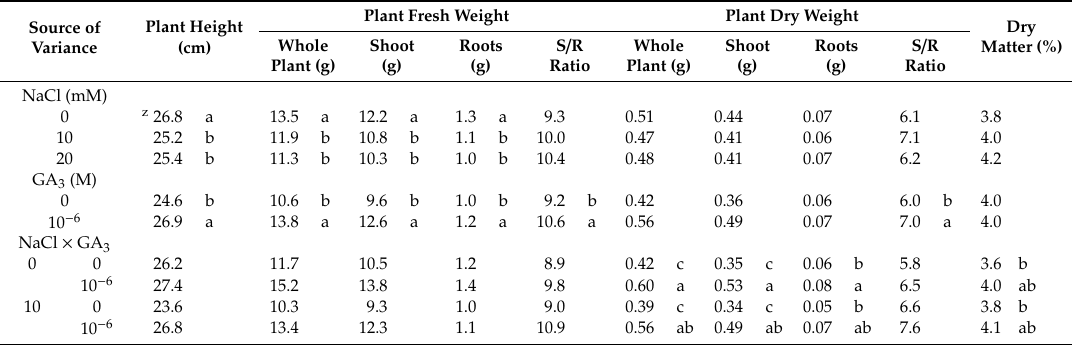
Table 1. Morphological parameters of leaf lettuce plants grown in nutrient solutions containing di ff erent levels of NaCl and GA 3